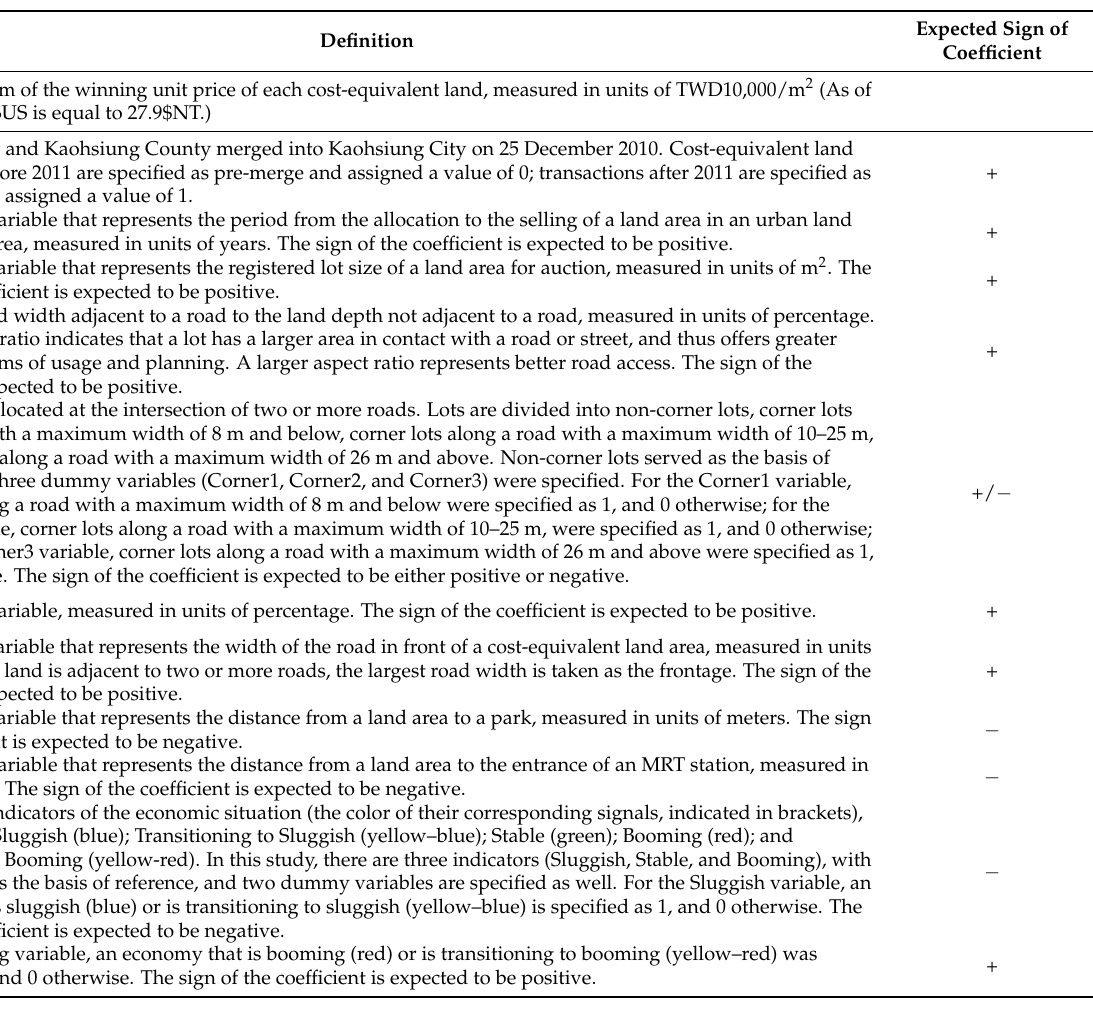
Table 1. Description of variable